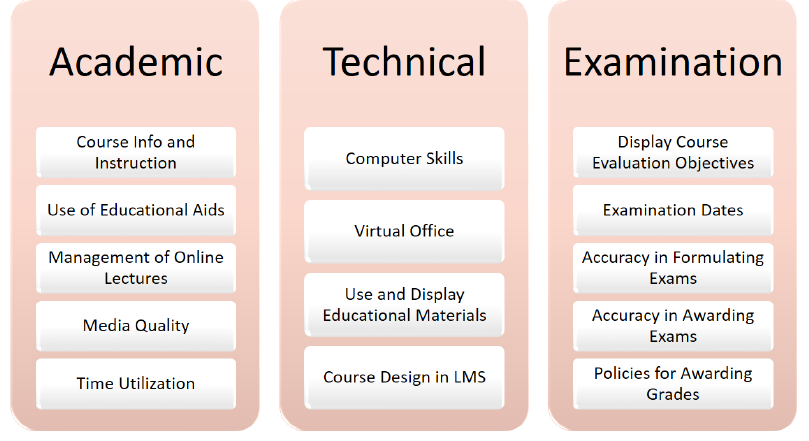
Figure 2. QTEF core